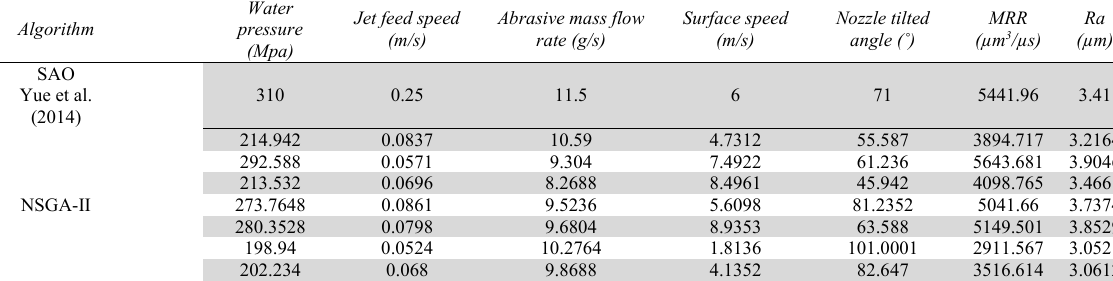
Comparison of NSGA-II results for AWJM